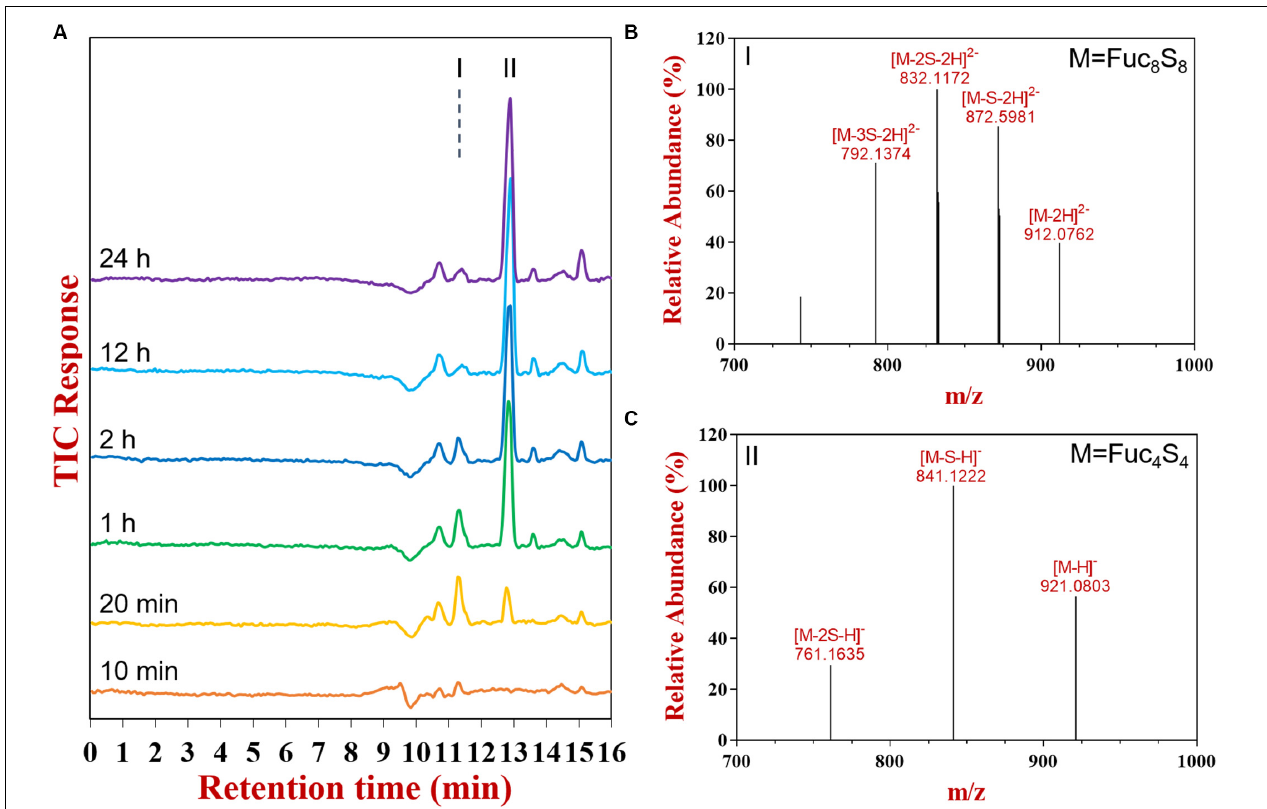
FIGURE 2 | The total ion chromatogram (A) , mass spectrums of component I (B) and II (C) as determined by